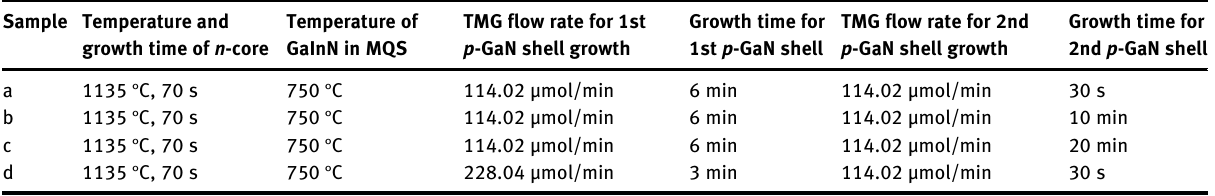
Table  : MOCVD growth parameters for nanowire samples. Sample Temperature and growth time of n -core